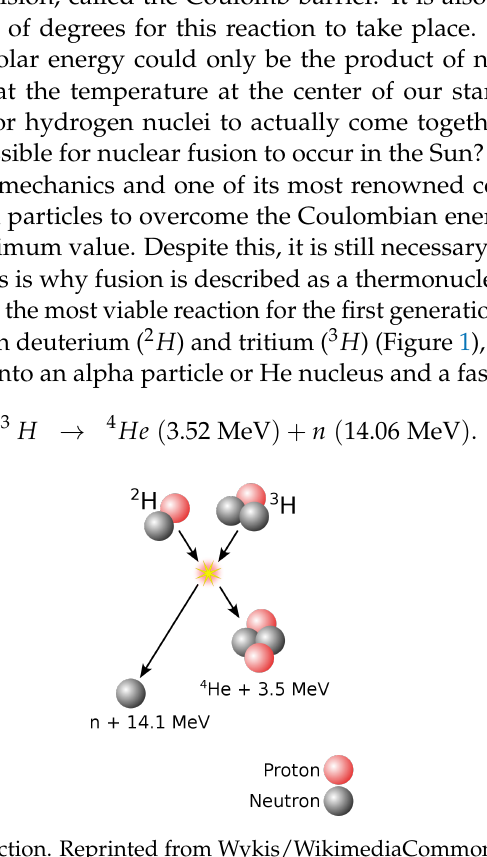
Figure 1. Nuclear fusion reaction. Reprinted from